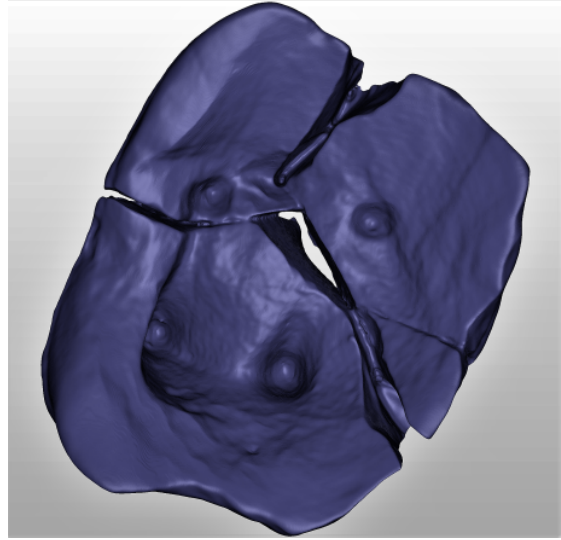
Figure 2. 3D reconstruction of enamel layer of sample 82